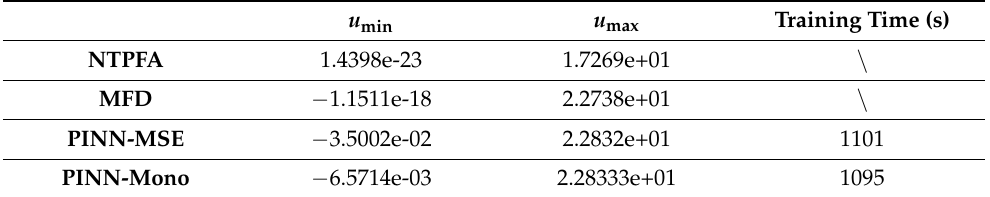
Table 4. Summary of computational results for case 2: k r = 1000. u min u